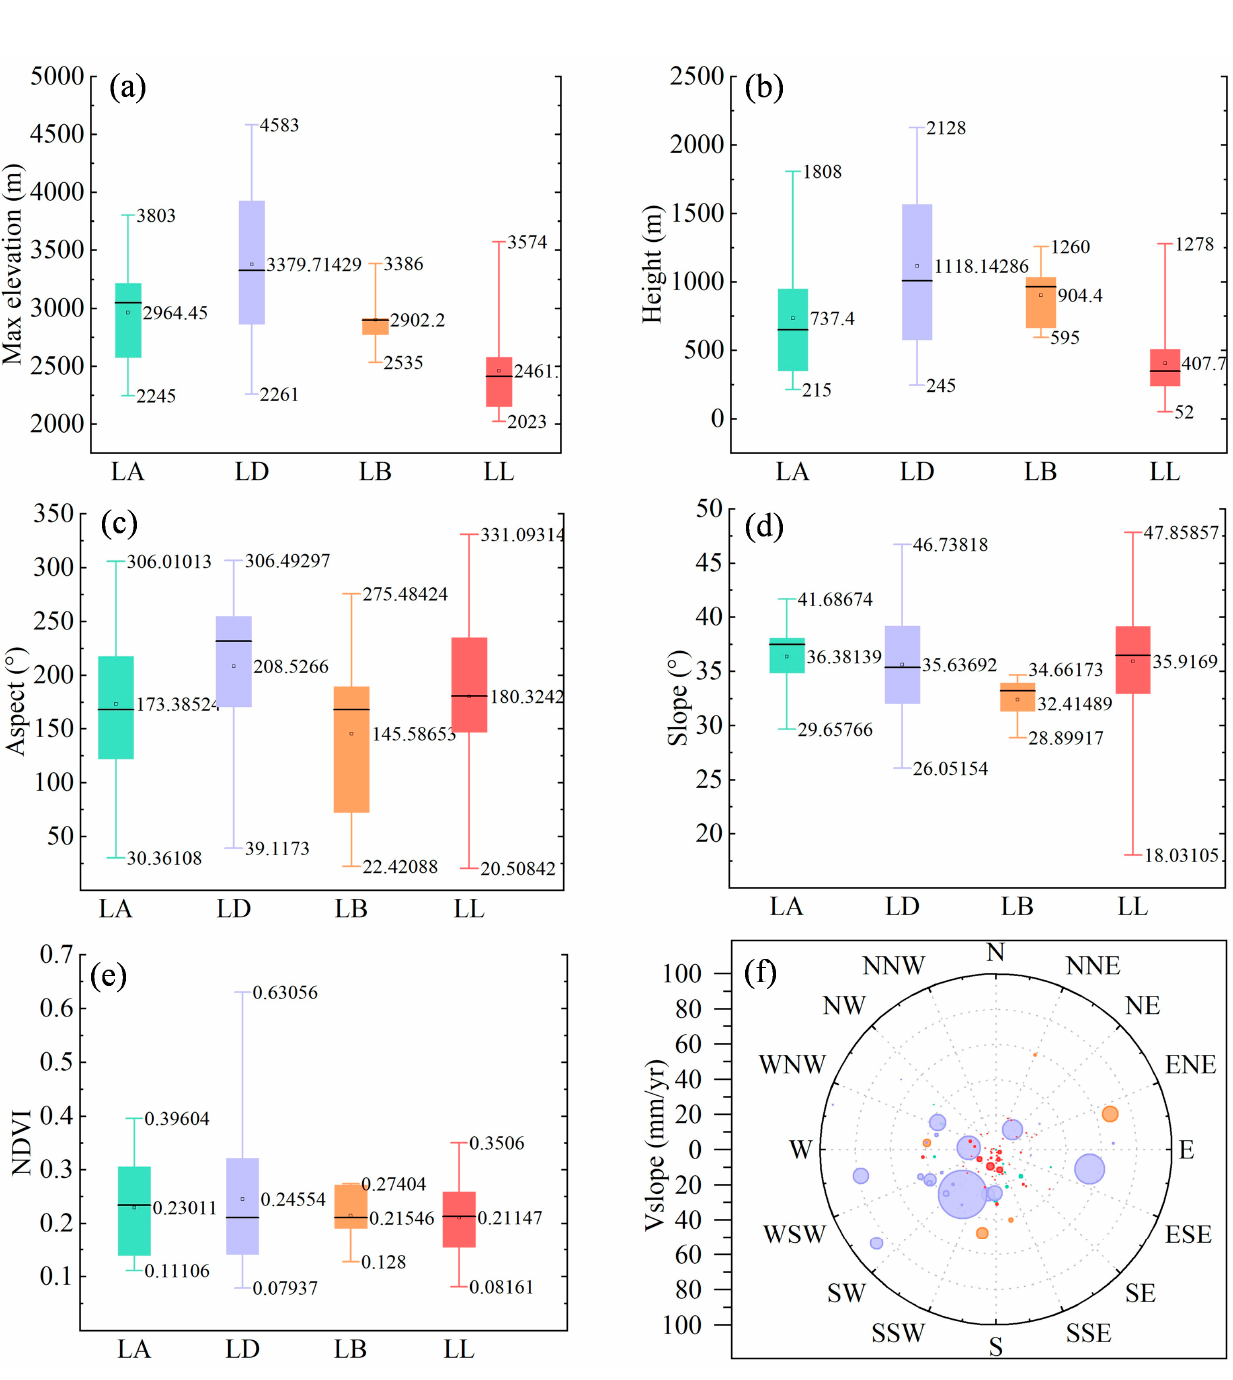
Figure 12. Analysis of multi-source landslide development characteristics of ( a ) elevation, ( b ) height, ( c ) slope aspect, ( d ) slope, and ( e ) NDVI, and ( f ) the colorful dots of different sizes indicate the landslide sources and their area. Its quadrant and radial locations represent the aspect and displacement velocity. The landslide statistics include landslides detected by ascending (LA), descending (LD), both ascending and descending datasets (LB) and the landslides from the literature (LL). The max–min–mean are marked on the graph.